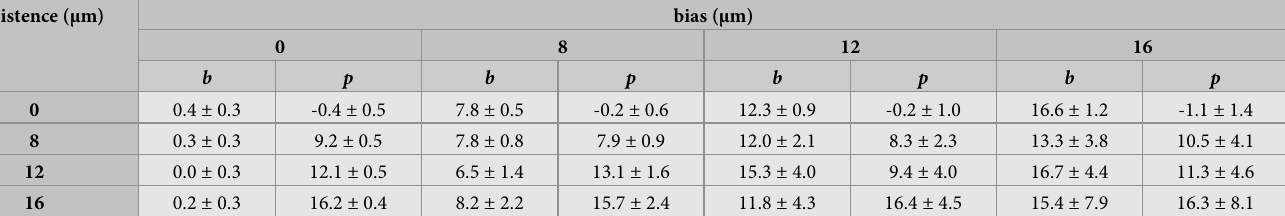
Table 2. Bias and persistence estimated from simulated cell populations.